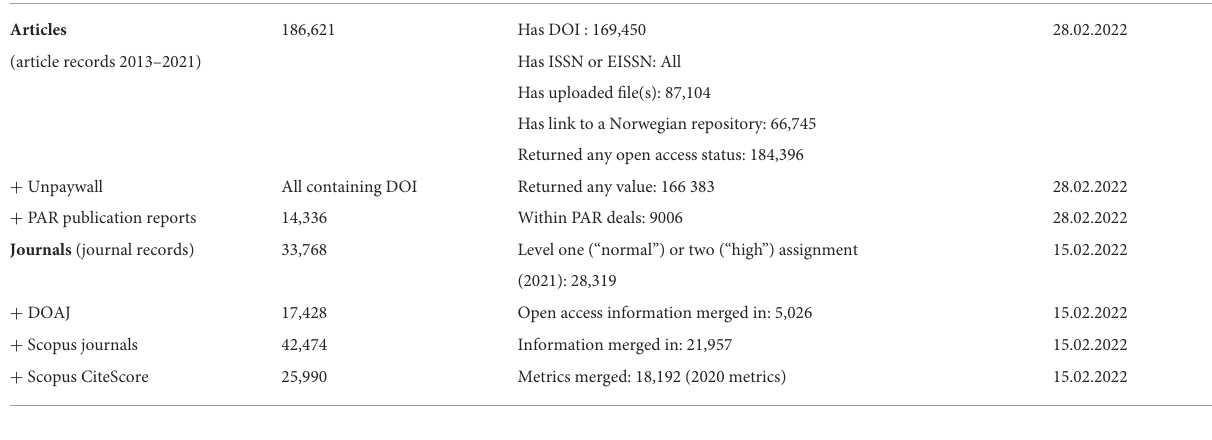
TABLE 1 Overview of data, sources, and enhancements.